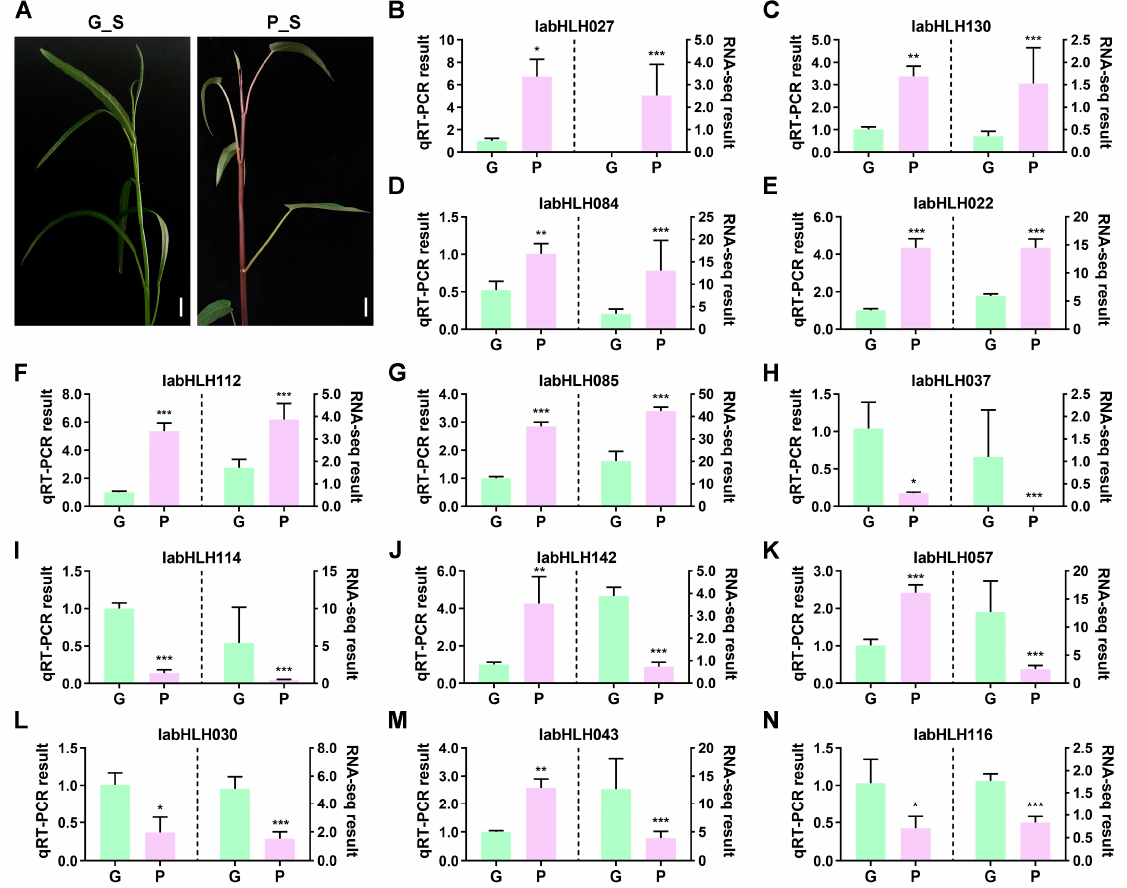
Figure 7. Expression analysis of the 13 DEGs. ( A ) The phenotype of two varieties. The G_S represents green-stemmed I. aquatica , while the P_S represents purple-stemmed I. aquatica . Scale bars are 2 cm. ( B – N ) The qRT-PCR validation of the expression trends of 13 DEGs was determined by RNA-seq. The left Y-axis and histogram indicated the relative expression levels of the IabHLH gene quantified by qRT-PCR. The right Y-axis and histogram indicate the FPKM values of the IabHLH gene obtained by RNA-seq datasets. Statistical analysis was performed using Student’s t -test. Data are shown as mean ± SD of three biological replicates. The *, **, and *** indicate p < 0.05, p < 0.01, and p < 0.001,